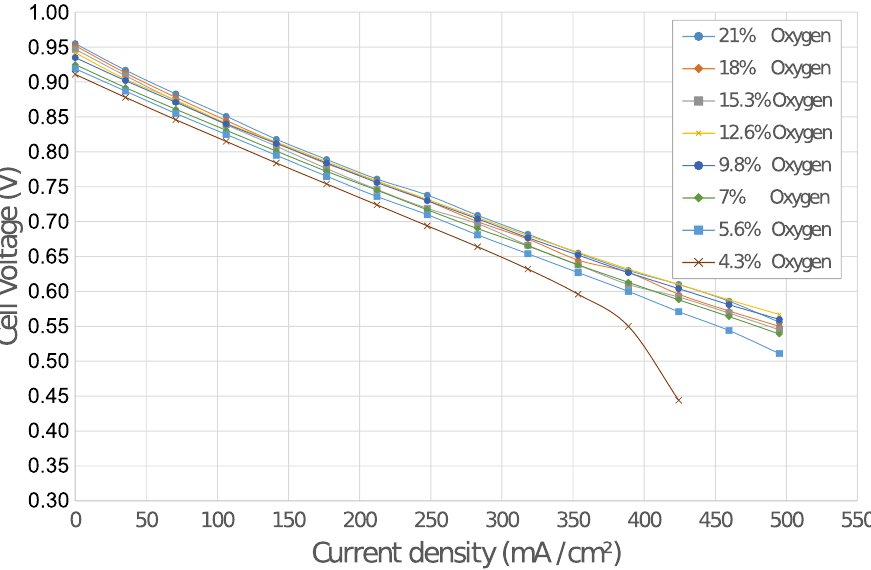
Figure 13. The performance of the cell operating at 900 ◦ C with decreasing partial pressure of oxygen—At 900 ◦ C, the performance of the cell is better than that of the cells operated at 800 ◦ C and 850 ◦ C. But its performance decreases for very low partial pressure of oxygen, smaller than 5.6%